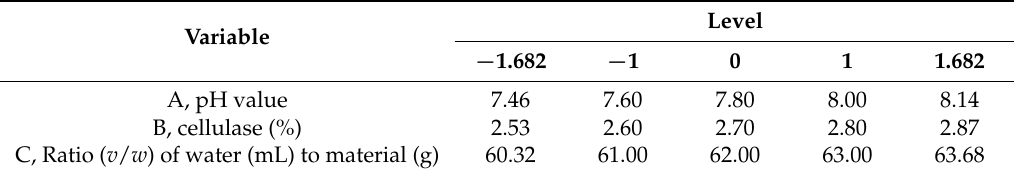
Table 3. The factors level coding table of the